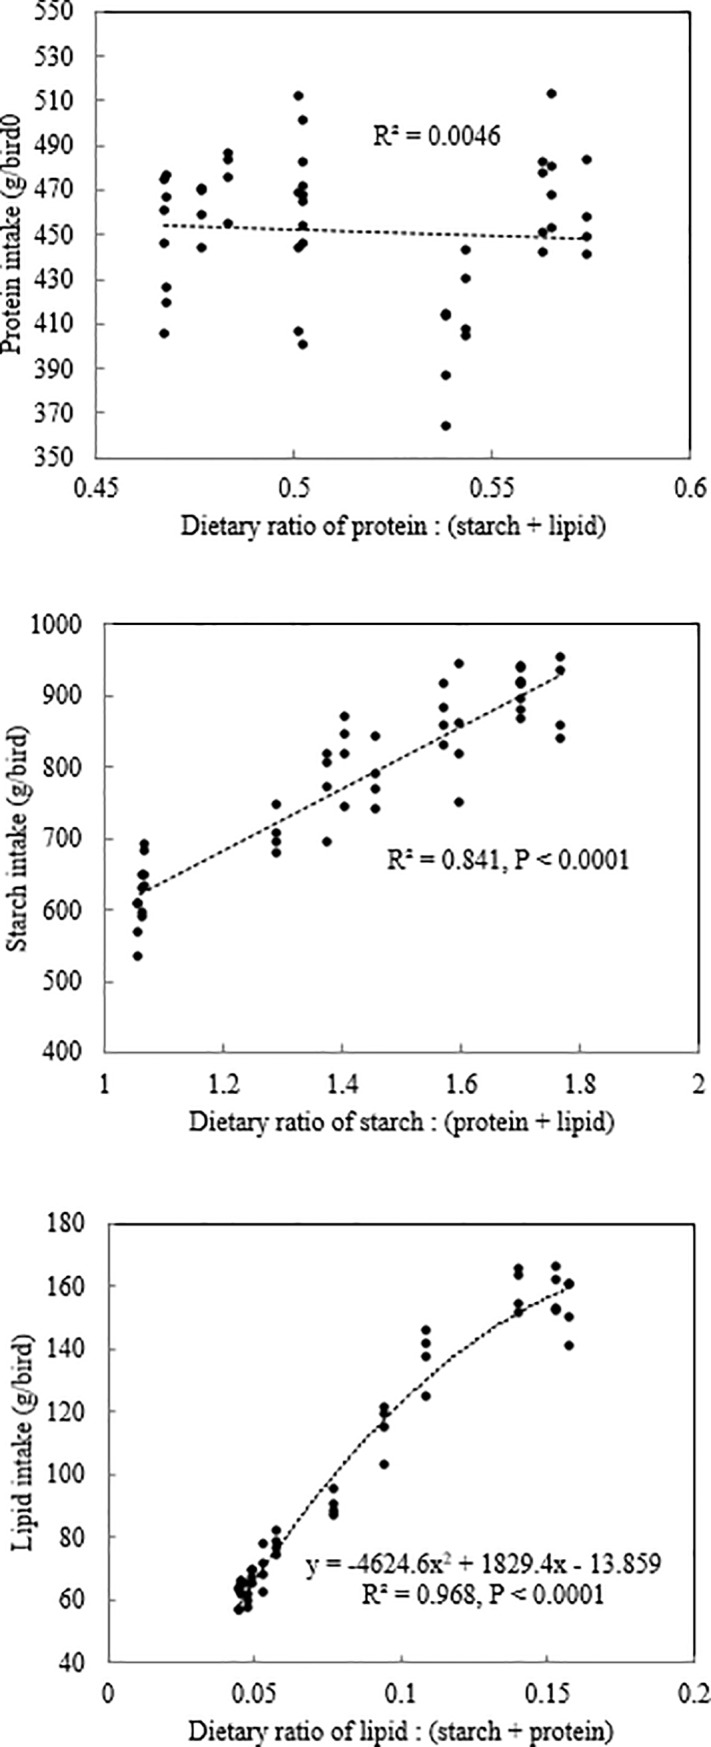
The relationships between nutrient to non-nutrient ratios and their corresponding nutrient intake from 7–27 days post-hatch.